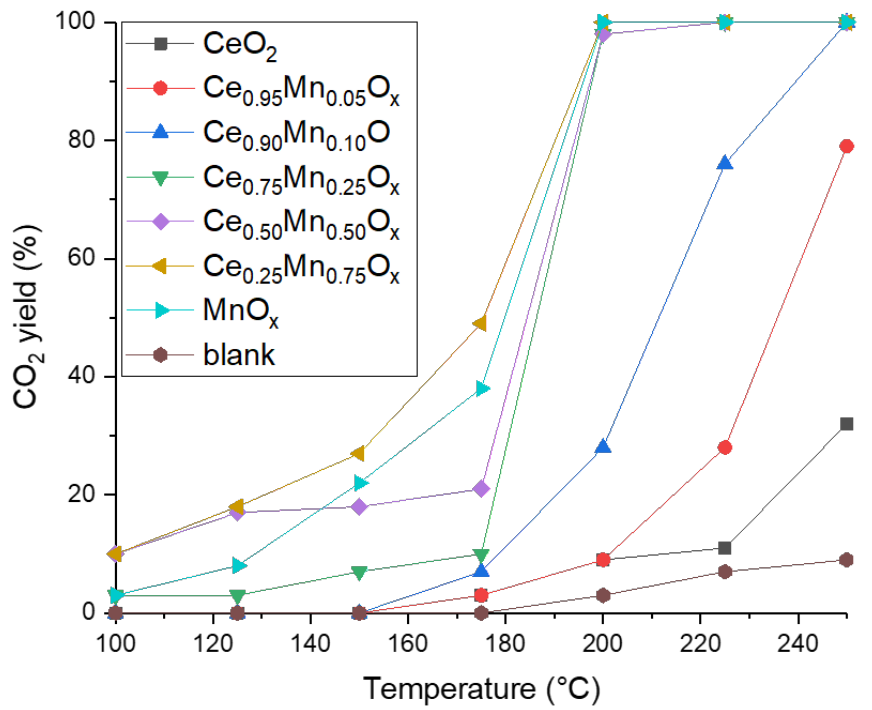
Figure 2. CO 2 yield as a function of temperature studying the total oxidation of naphthalene for cerium-manganese mixed metal oxide catalysts prepared by sodium carbonate co-precipitation. Reaction conditions: 100 ppm naphthalene/20% O 2 /He, Gas Hourly Space Velocity (GHSV) = 45,000 h − 1 , Temperature range = 100 –250 °C.